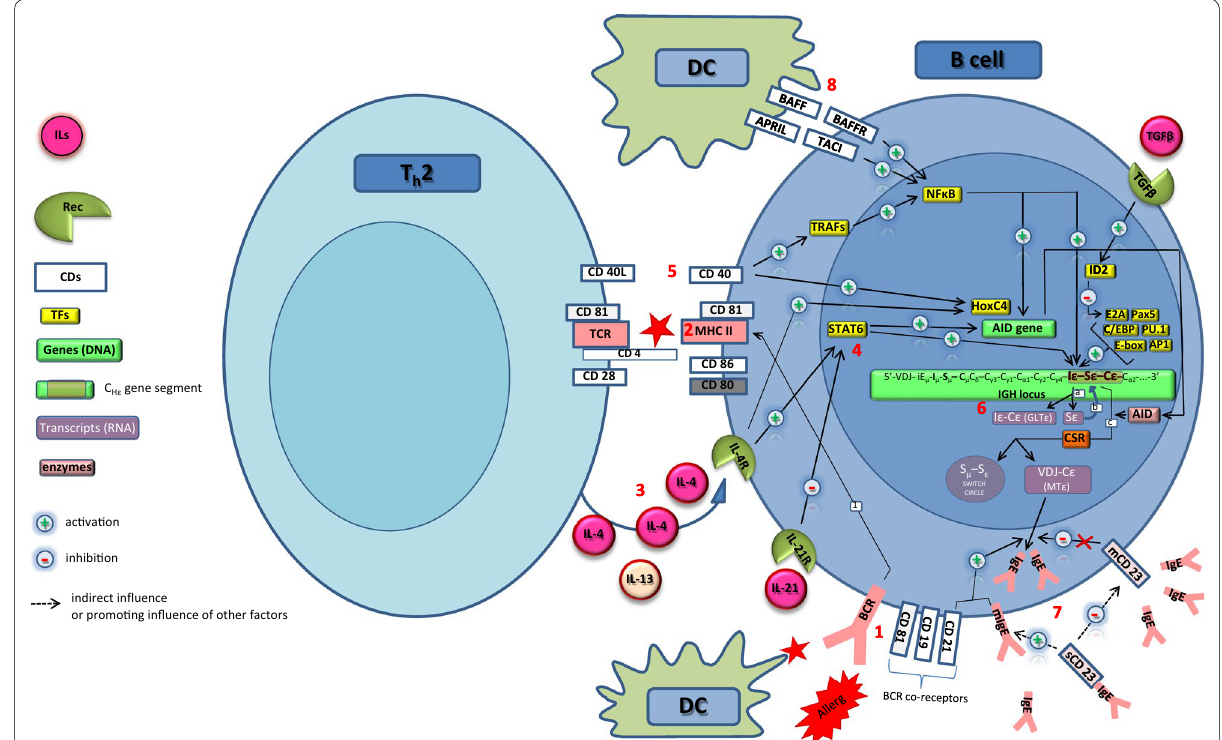
Fig. 4 IgE isotype switching in B cells. The surface immunoglobulin that serves as the B‑cell antigen receptor (BCR) has two roles in B‑cell activation. First, in combination with the BCR co‑receptors, it transmits signals directly to the cell’s interior when it binds antigen (event 1). Second, the B‑cell antigen receptor delivers the antigen to intracellular sites where it is degraded and returned to the B‑cell surface as peptides bound to MHC class II molecules (event 2). Subsequent isotype switching of B cells to IgE production is induced by two separate signals, both of which can be provided by polarized Th2 cells. The first signal is provided by the cytokine IL‑4 interacting with the IL4 receptor on the B cells (event 3), which leads to activa‑ tion of STAT‑6 (event 4). The second signal for IgE switching is a co‑stimulatory CD40‑CD40L interaction (event 5). Both signals are important for the initiation of the antibody class switching (event 6), resulting in IgE production (event 7). It is also possible to induce a CD40‑independent induction of isotype switching which involves the interaction of BAFF‑BAFFR and APRIL‑TACI interactions between DC and B cells (event